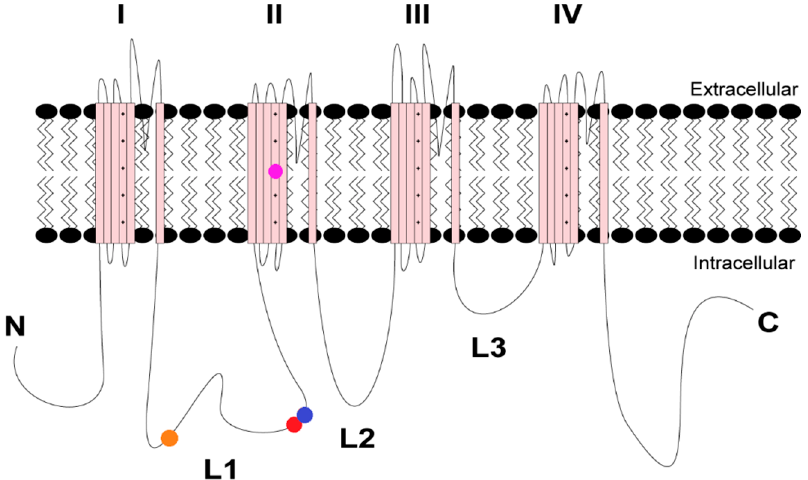
Figure 1. Topology of voltage-gated sodium channel SCN8A . The R639C and R850Q mutations are denoted in red and fuchsia, respectively. The CaMKII phosphorylation sites S561 and T642 in L1 of the channel are in orange and blue, respectively. The four pseudo-domains are indicated with the Roman numerals I–IV and the three large intracellular loops with L1–L3.